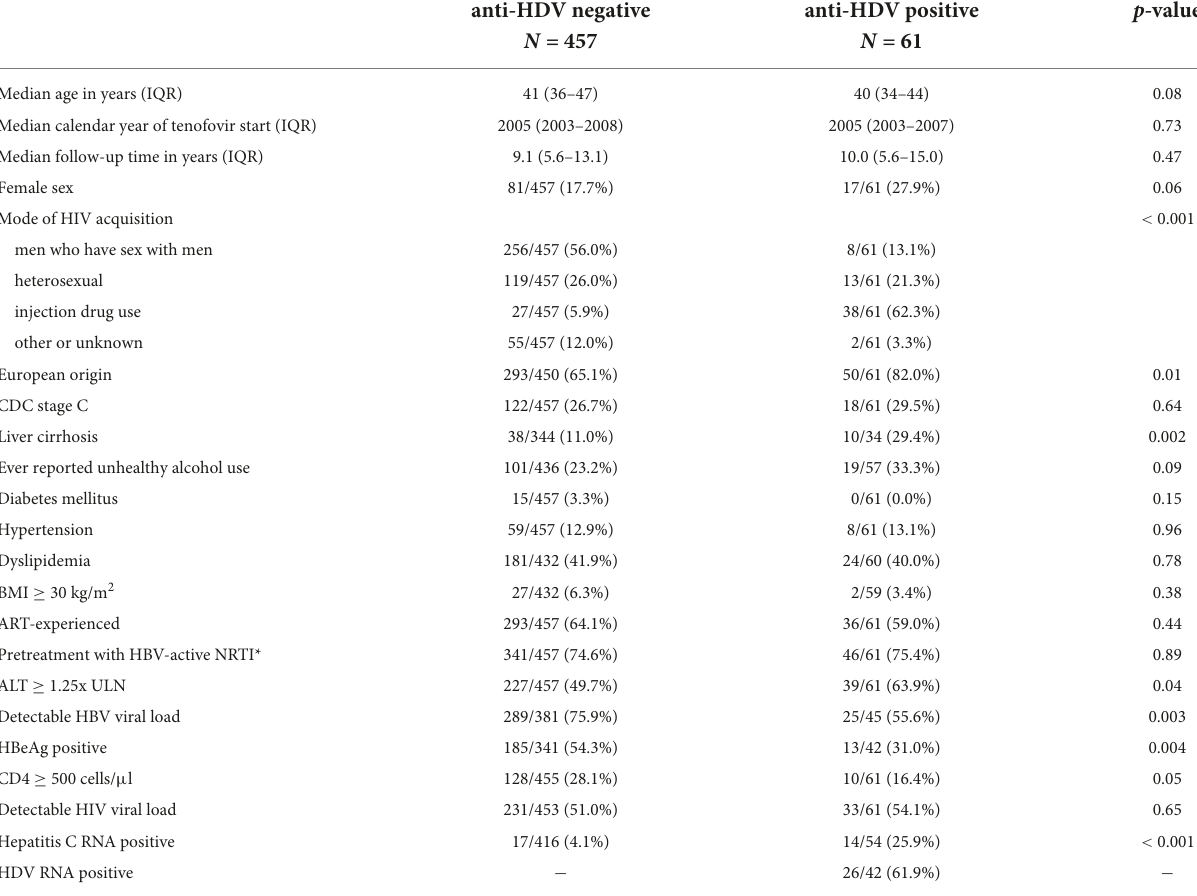
TABLE 1 Characteristics of Euro-B participants at start of tenofovir-containing antiretroviral therapy (ART), by anti-hepatitis delta antibody (anti-HDV)